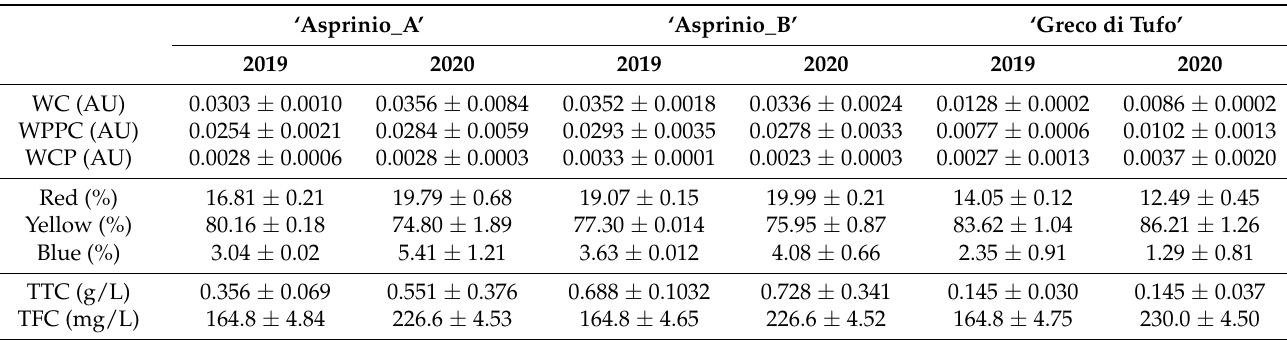
Table 1. Colourimetric parameters (WC, wine colour; WPPC, wine polymeric pigment content; WCP, wine colour pigment), total tannins content (TTC) and total flavonoids content (TFC) of wine samples. Values are expressed as mean ± SD ( n =